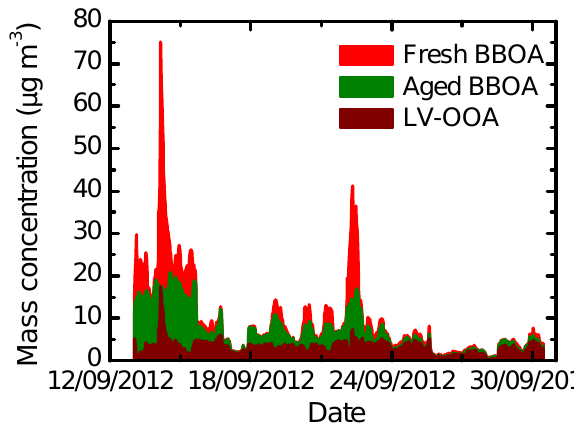
Figure 11. Organic aerosol loading time series with color-coded contributions of identified PMF factors.